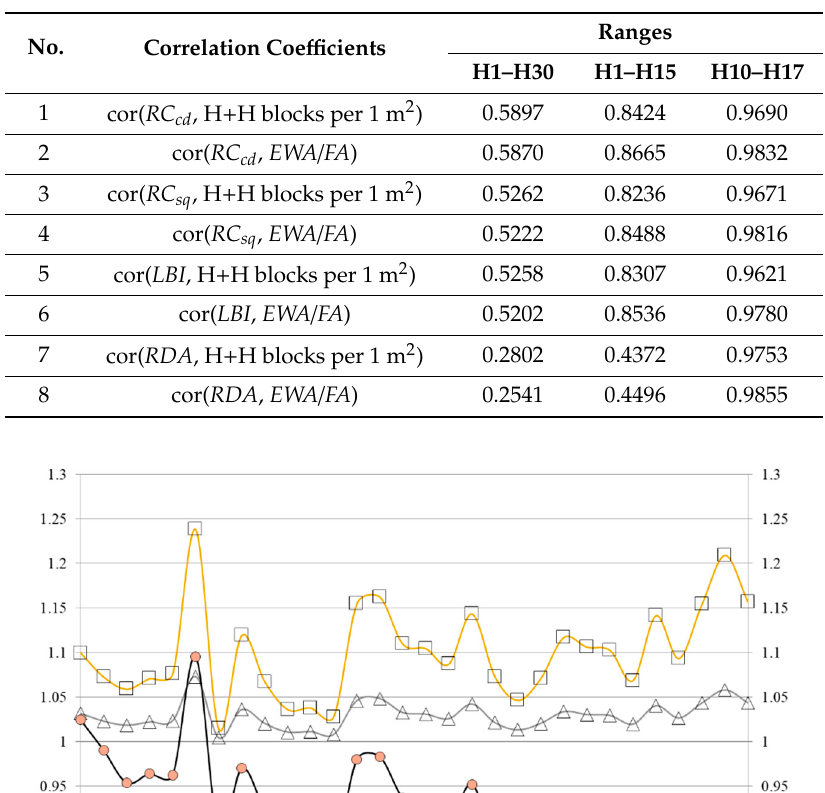
Table 1. The dependence of the correlation coe ffi cient of the relative compactness indicator with respect to the cuboid ( RC cd ), the relative compactness indicator with respect to a square ( RC sq ), Banks length / breadth index ( LBI ), and relative defects of an area ( RDA ) indices on the range of changes in the built-up area of buildings belonging to H1–H30. EWA / FA : the ratio of the external walls area to the floor area.